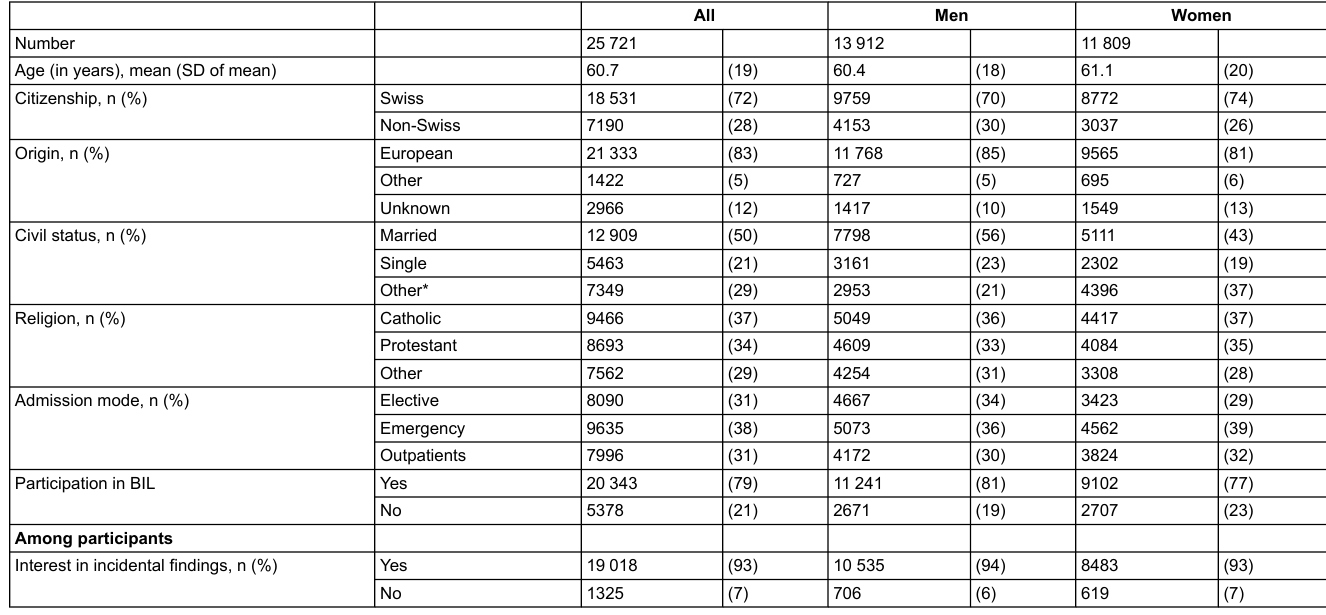
Table 1: Patient characteristics, overall and by